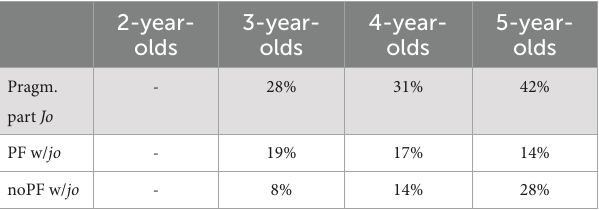
TABLE 6 Productions of the Norwegian sentence-internal pragmatic particle jo by age group ( N = 36).